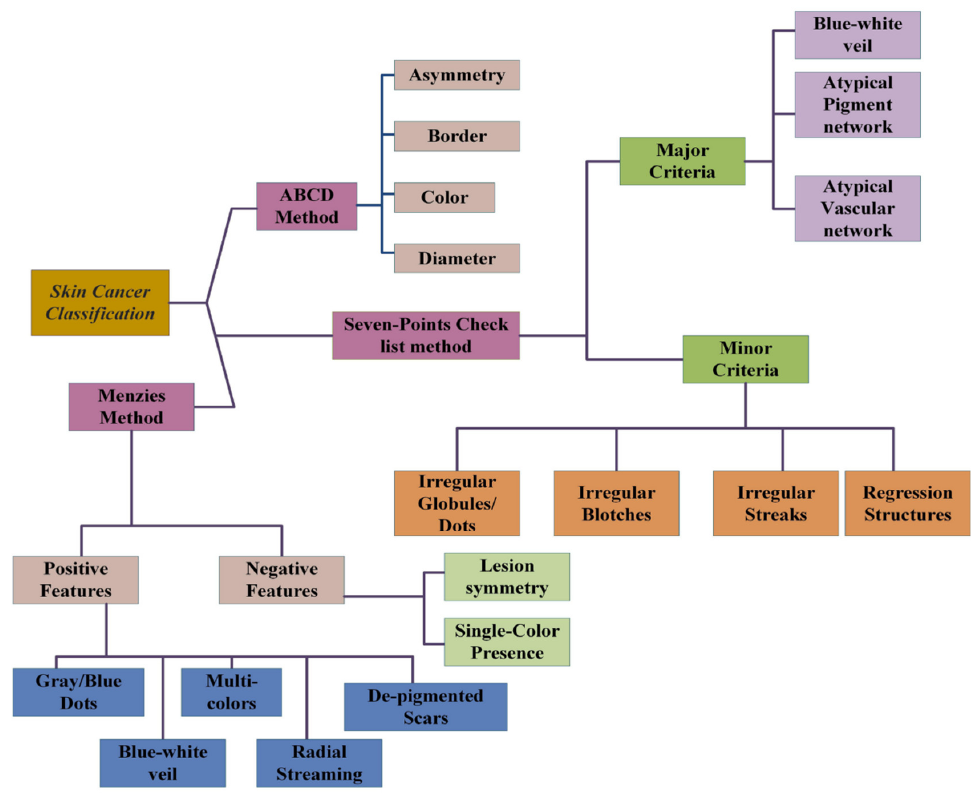
Figure 2. Summary used for skin cancer identification